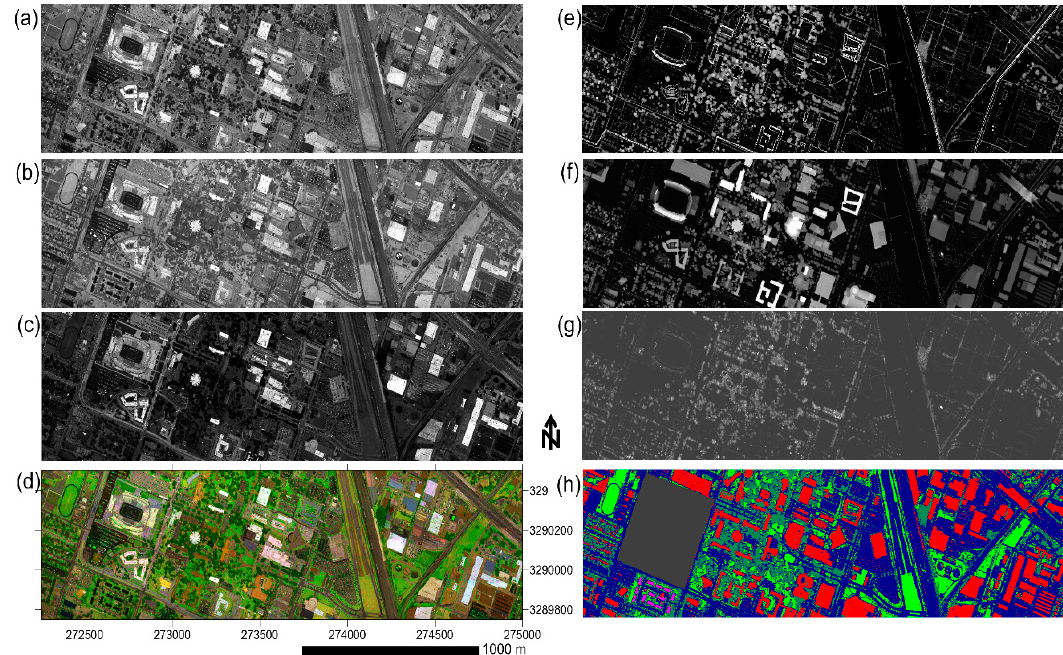
Figure 5. Intensity and structural images generated from the Titan multispectral data. ( a ) Intensity image generated from the 1550 nm channel; ( b ) intensity image for the 1064 nm channel; ( c ) intensity image for the 532 nm channel; ( d ) false color multispectral intensity image generated by using the 1550 nm intensity for the red channel and the 1064 and 532 nm intensities for the green and blue channels; ( e ) structural image based on the spread of the returns height; ( f ) structural image based on the height above ground; ( g ) structural image based on the number of returns per pulse; ( h ) ground cloud classification results map.